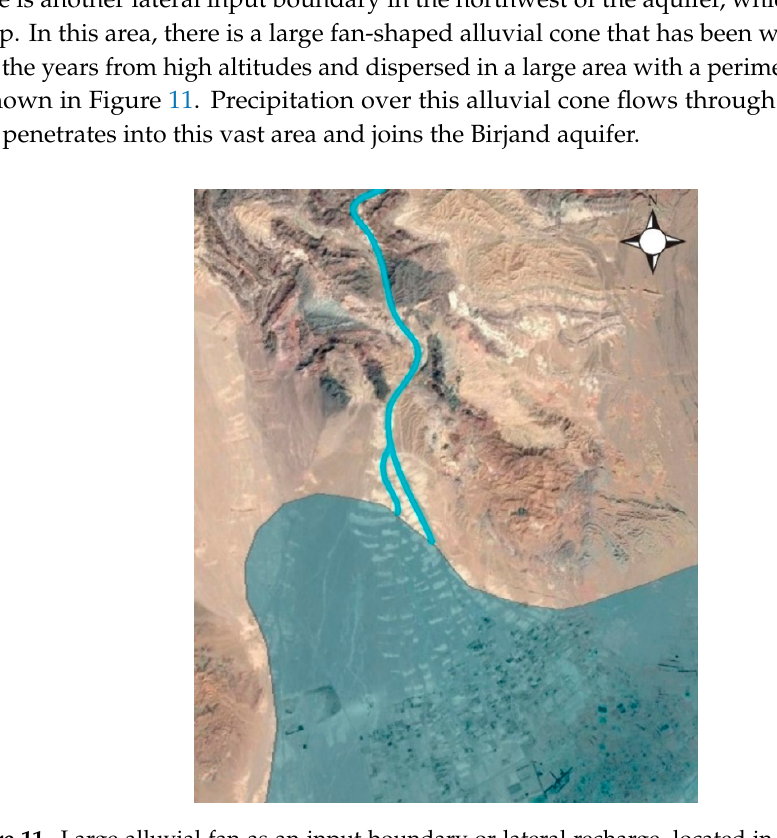
Figure 11. Large alluvial fan as an input boundary or lateral recharge, located in the northwest of Birjand aquifer. The blue line shows the groundwater lateral recharge way.